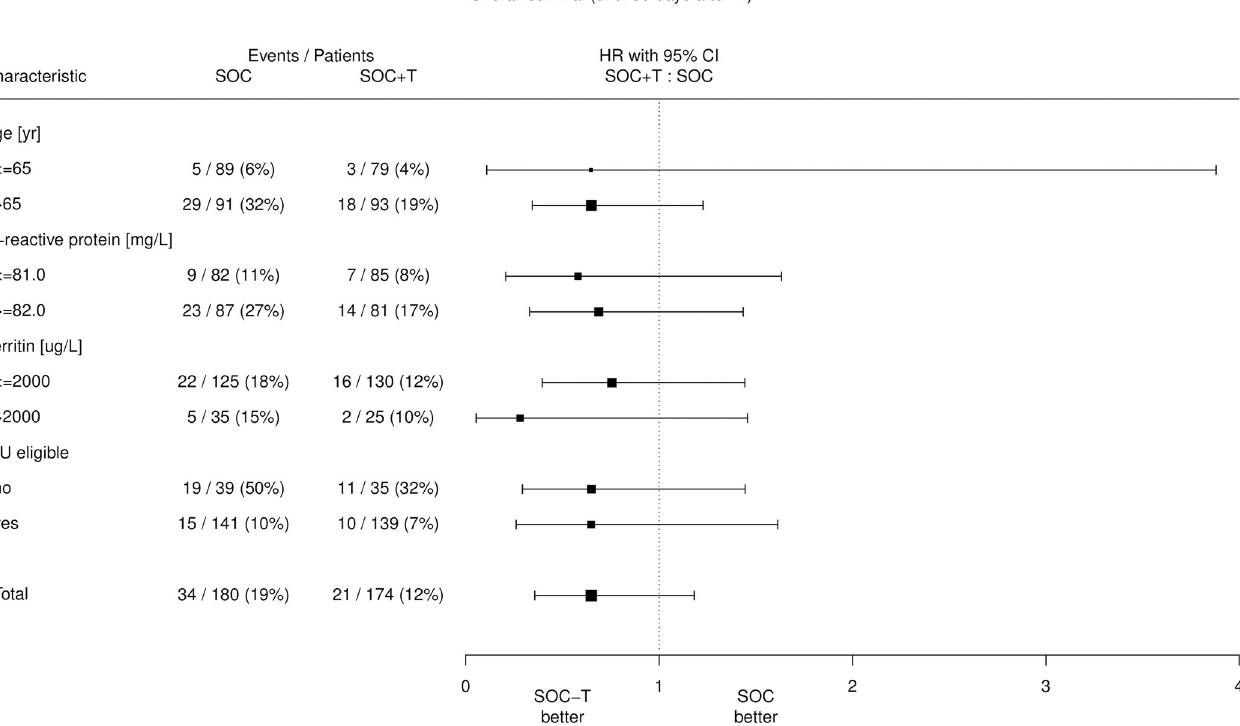
PLOS ONE | https://doi.org/10.1371/journal.pone.0271807 August 12,